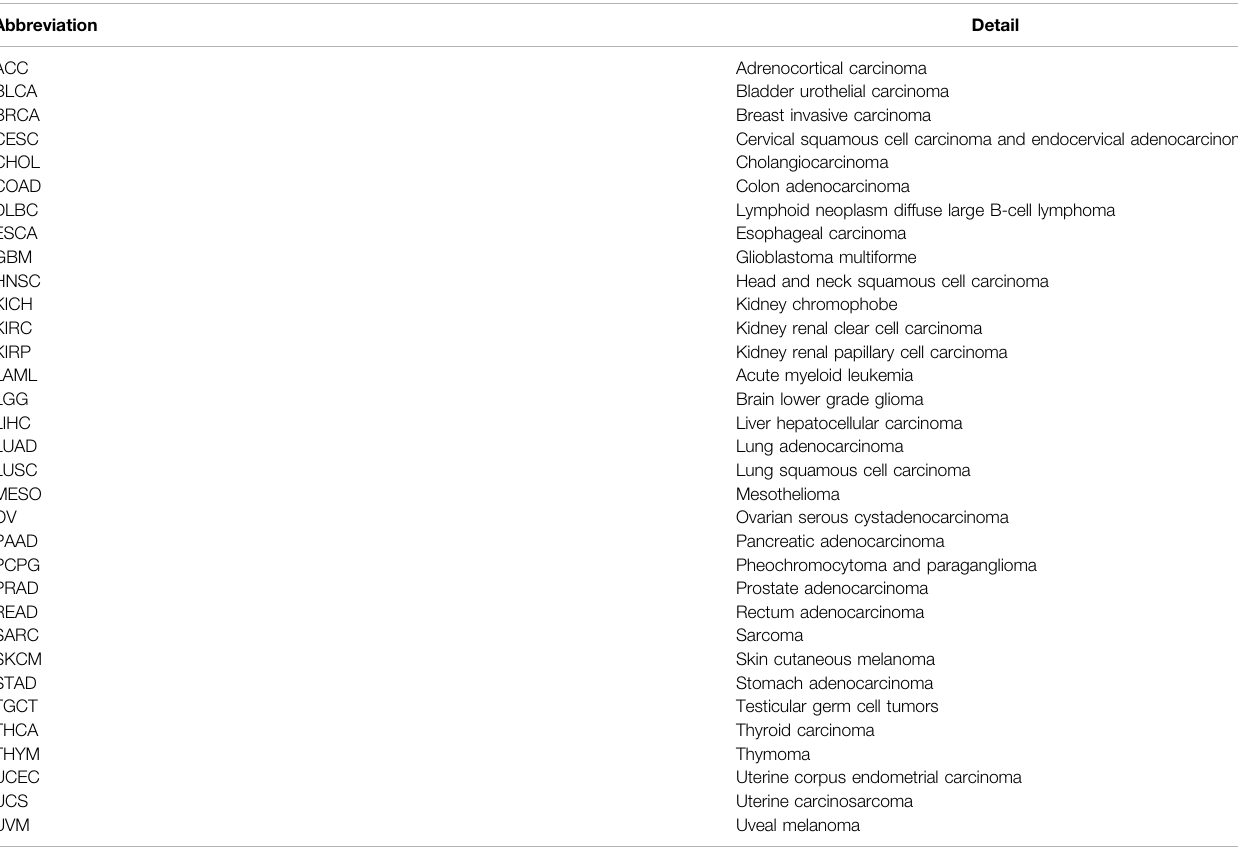
TABLE 1 | Abbreviations and details of the 33 cancer types used in this